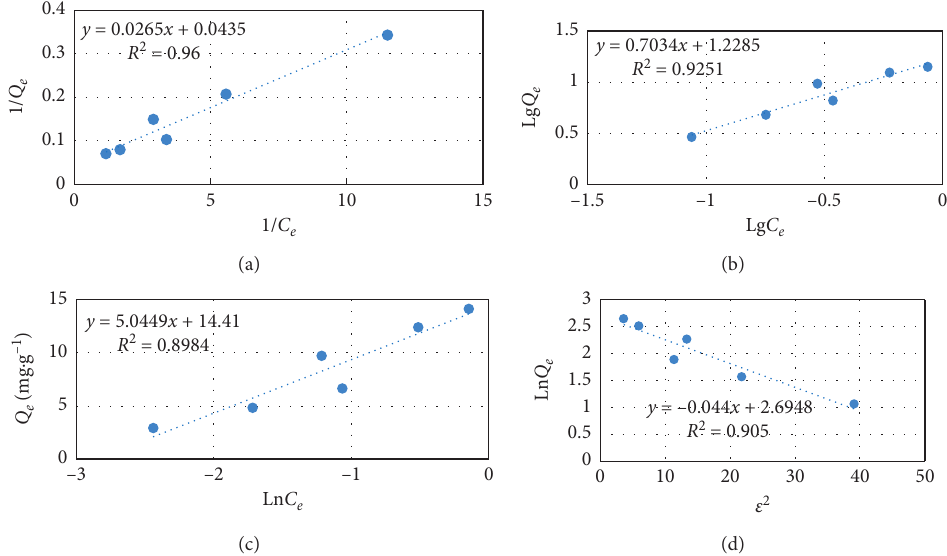
Figure 10: Four isotherm models with equations and correlation coefficient values of MB adsorption using YPS. (a) Langmuir adsorption Table 14: Parameters for plotting adsorption isotherms of MB adsorption using YPS.